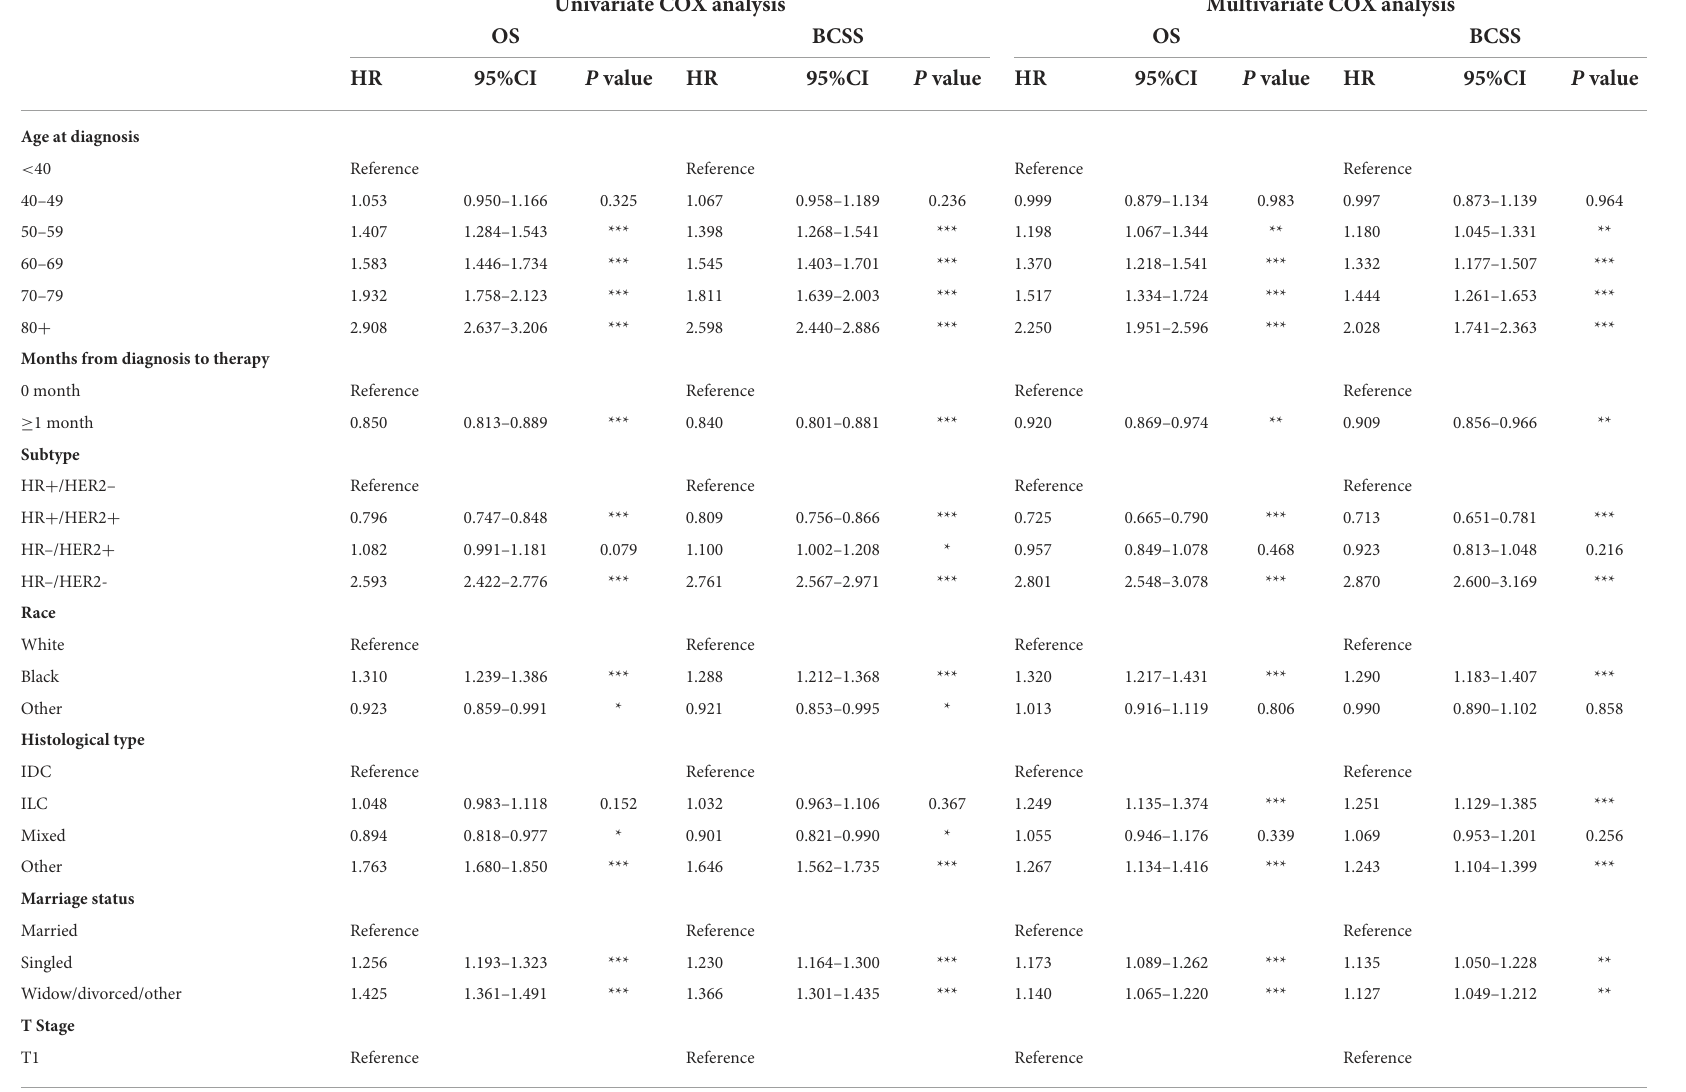
TABLE 2 Univariate and multivariate COX analyses of characteristics extracted from the SEER